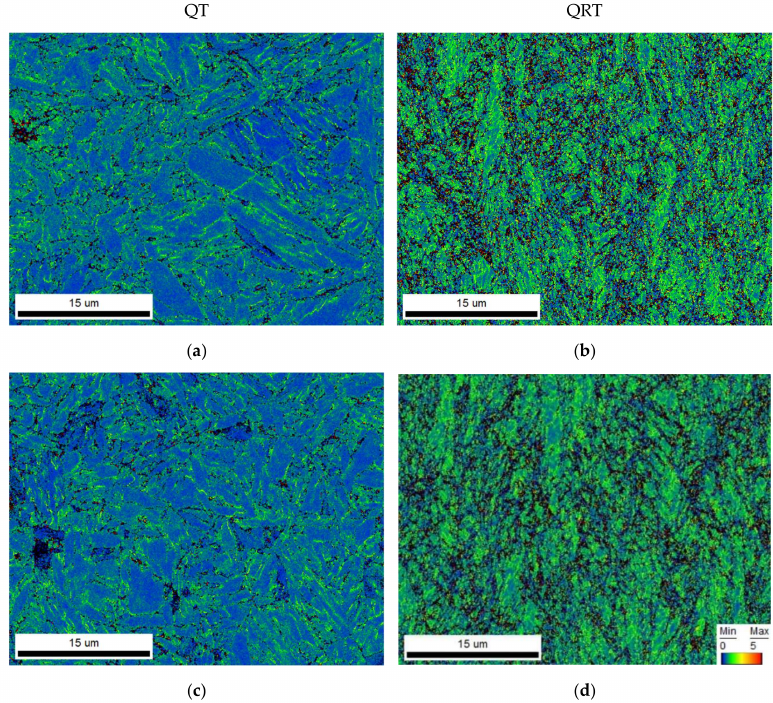
Figure 11. Kernell average misorientation (KAM) maps for the 0Cu and 1.5Cu materials tempered for 60 min at temperature 500 ◦ C: ( a ) 0Cu QT; ( b ) 0Cu QRT; ( c ) 1.5Cu QT; ( d ) 1.5Cu QRT. The map step was 0.05 µ m. Each pixel is colored according to its average misorientation with its six neighbors (maps were acquired in a hexagonal pixel pattern). The legend is in ( d